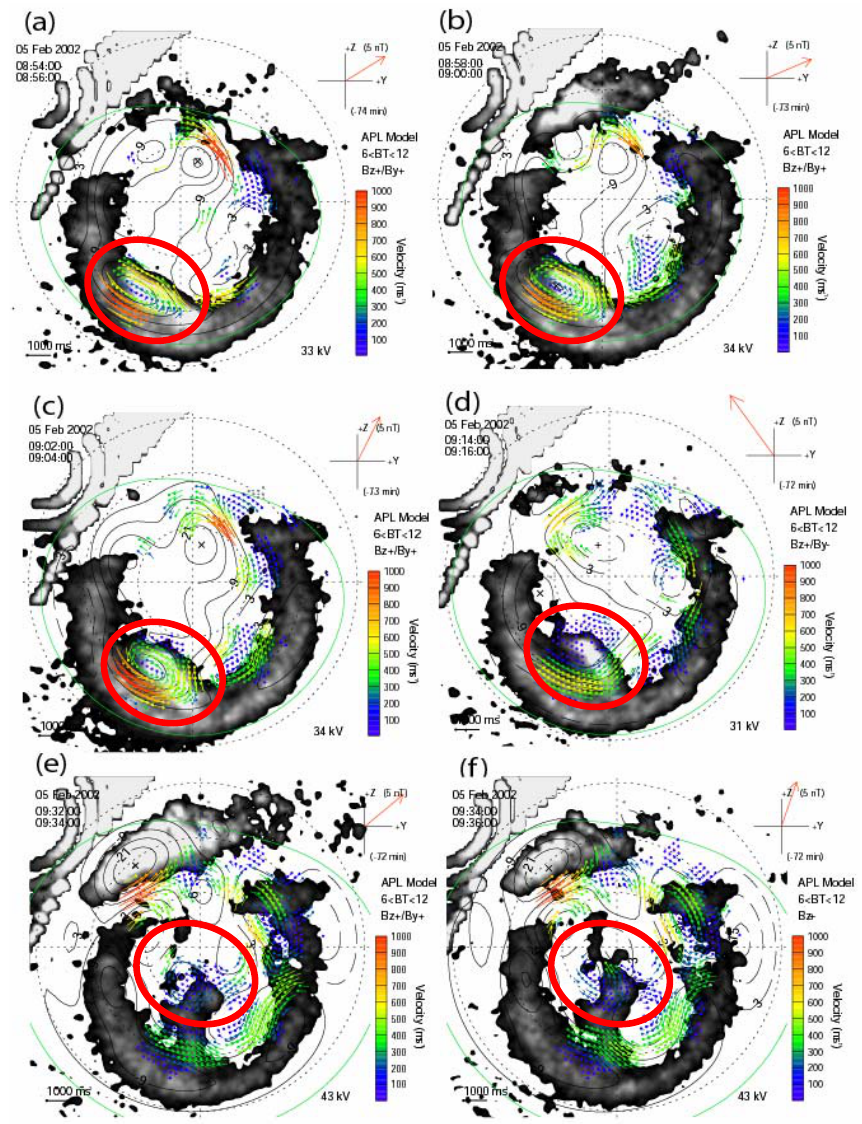
Fig. 7. SuperDARN convection maps with superimposed IMAGE FUV auroral data. Marked with red ovals are locations of the vortical